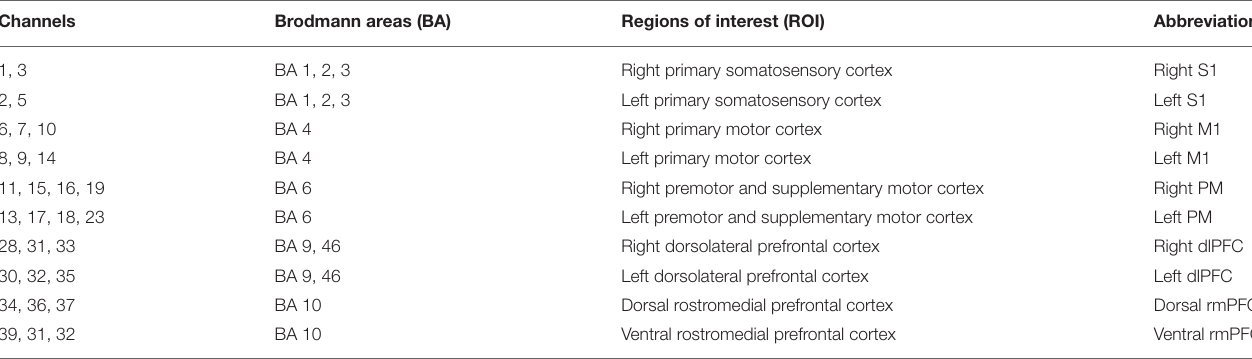
TABLE 1 | Anatomically labeled fNIRS channel locations using Brodmann areas. Channels